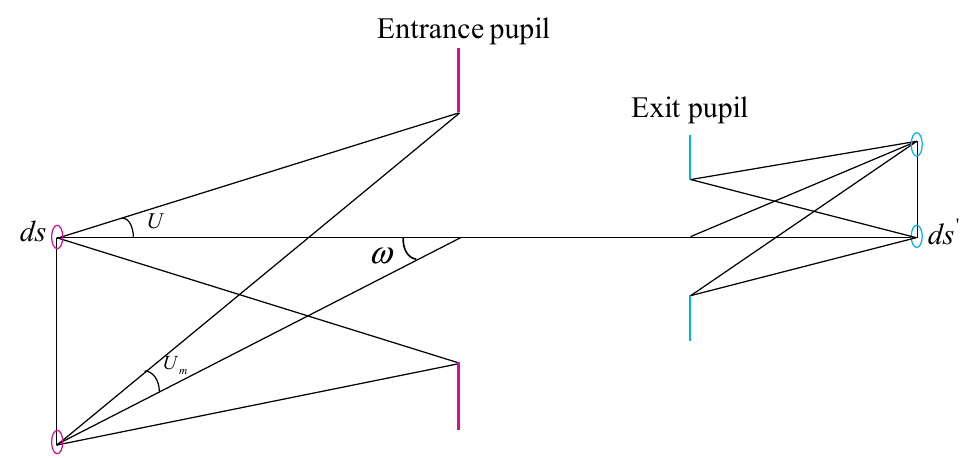
Figure 5. Transfer relation between object and image in optical system.